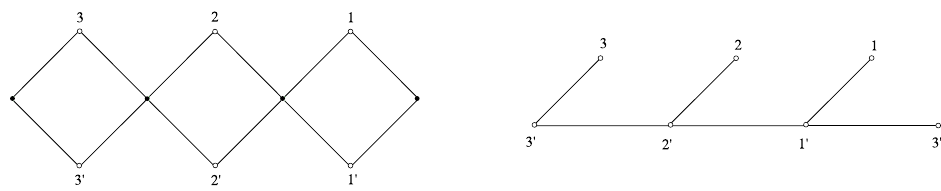
Figure 17 . Left: integral kernel of the transfer matrix operator t ( a ) ( u ) for a spin chain of length L = 3 , for auxiliary and physical spaces in the representation of zero spins ‘ a = ‘ k = 0 and ˙ ˙ ‘ a = ‘ k = 0 and ∆ k = ∆ a = 1 . Right: at the point u = − 1 and θ = 0 (or, equivalently, u → − 1 / 2 and θ = − ∆ / 2 = − 1 / 2 ) the transfer matrix kernel reduces to the graph-building operator ˆ B for the planar Feynman integrals of the bi-scalar Fishnet theory